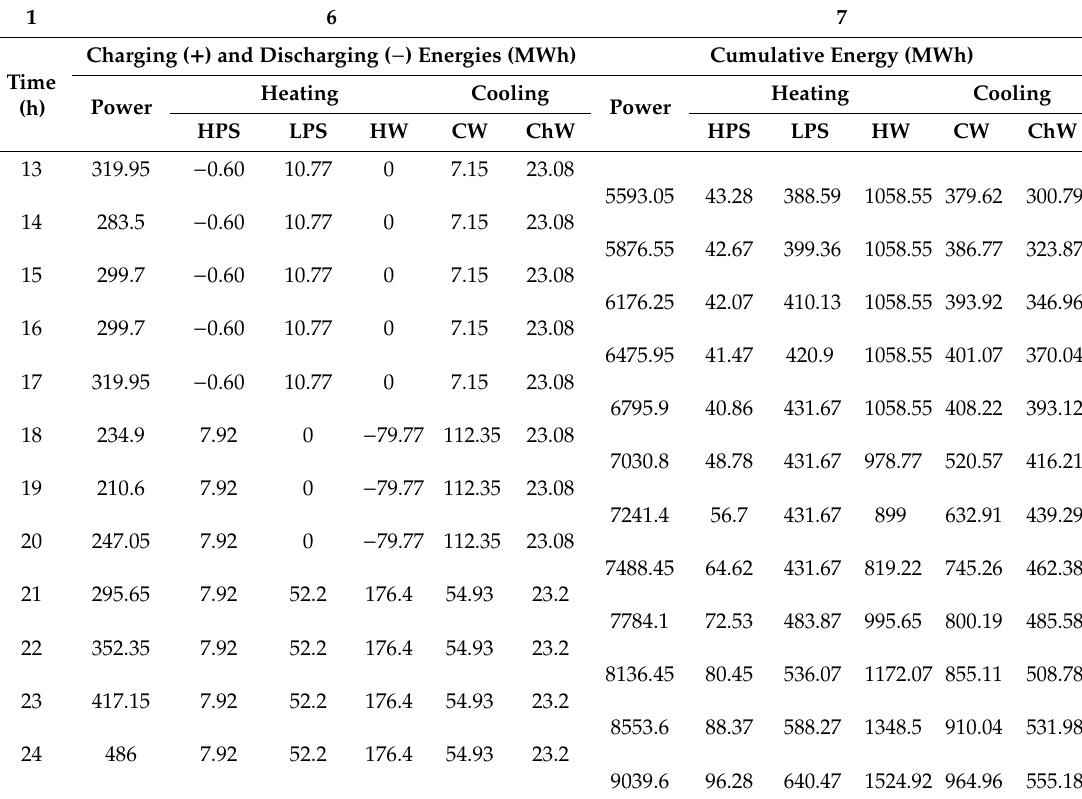
Table A6. TriGenSCA before iteration from time 13 to 24 h.